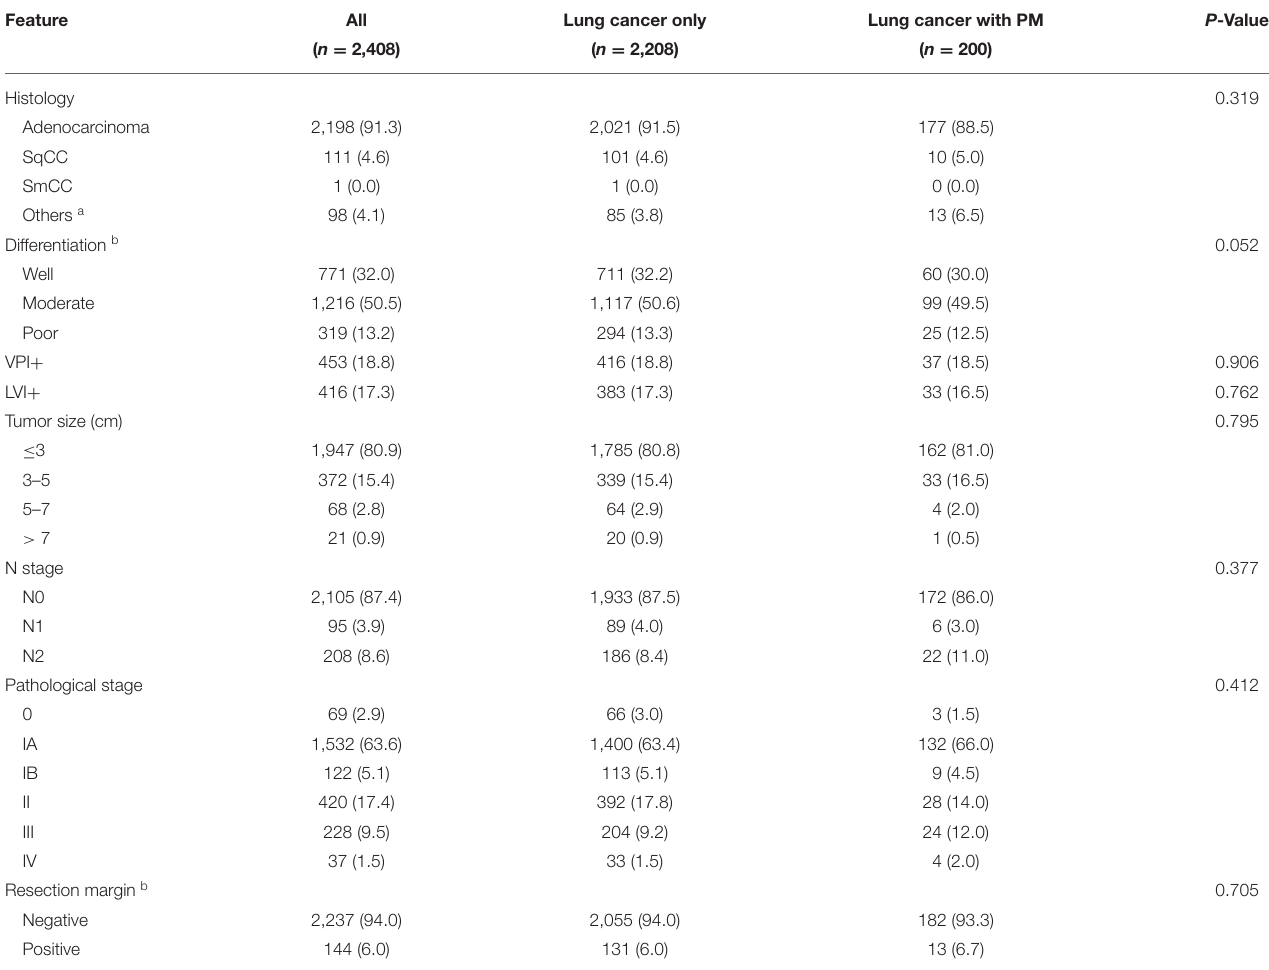
TABLE 2 | Pathological features of the excised lung